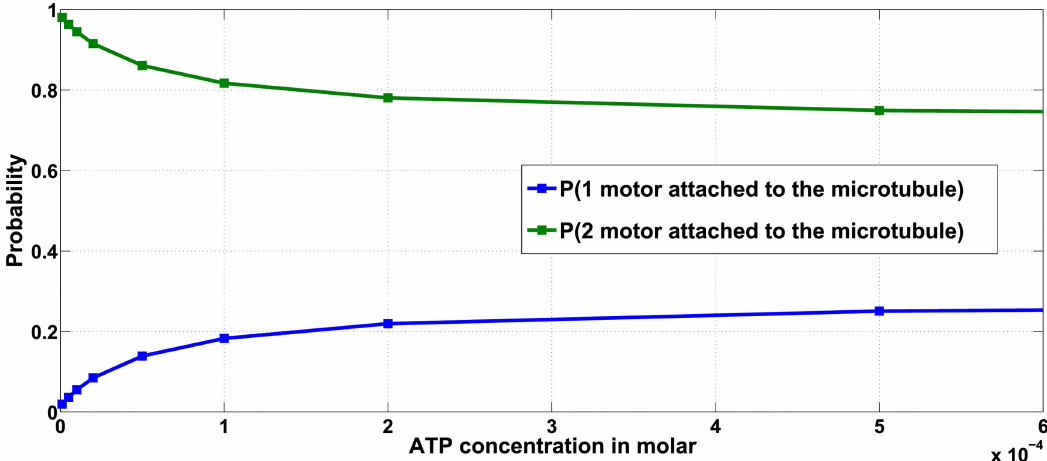
Fig 14. Effect of ATP concentration on run-length for ensemble